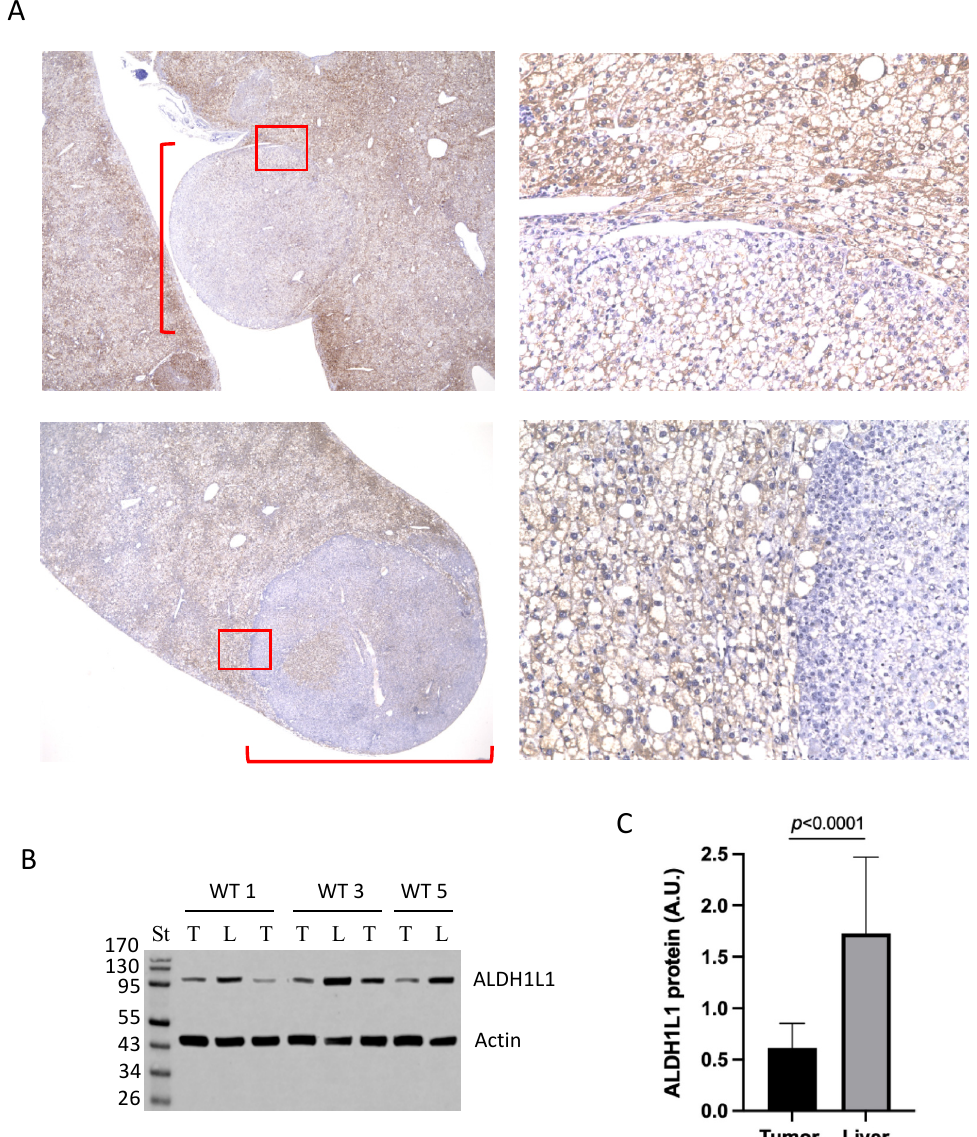
Figure 2. Levels of ALDH1L1 protein in large tumors grown in Aldh1l1 +/+ mice. ( A ) Immunohisto- chemical staining of large tumors (36 weeks post-DEN injection) in Aldh1l1 +/+ mice with ALDH1L1-specific antibody. Large tumors (from two mice) are marked with a red square bracket (2x magnification). Areas marked with red squares are shown at higher magnification (20×) on the right panels. ( B ) Western blot assay of large tumors (T) and normal liver tissues (L) of Aldh1l1 +/+ mice (3 mice, WT1, 3, and 5) with ALDH1L1-specific antibody. ( C ) Calculated intensities of ALDH1L1 bands normalized to actin (Image J), arbitrary units (A.U.). Experiments for all samples were repeated three times (technical replicates); the calculation includes all replicates (biological and technical; p < 0.0001).